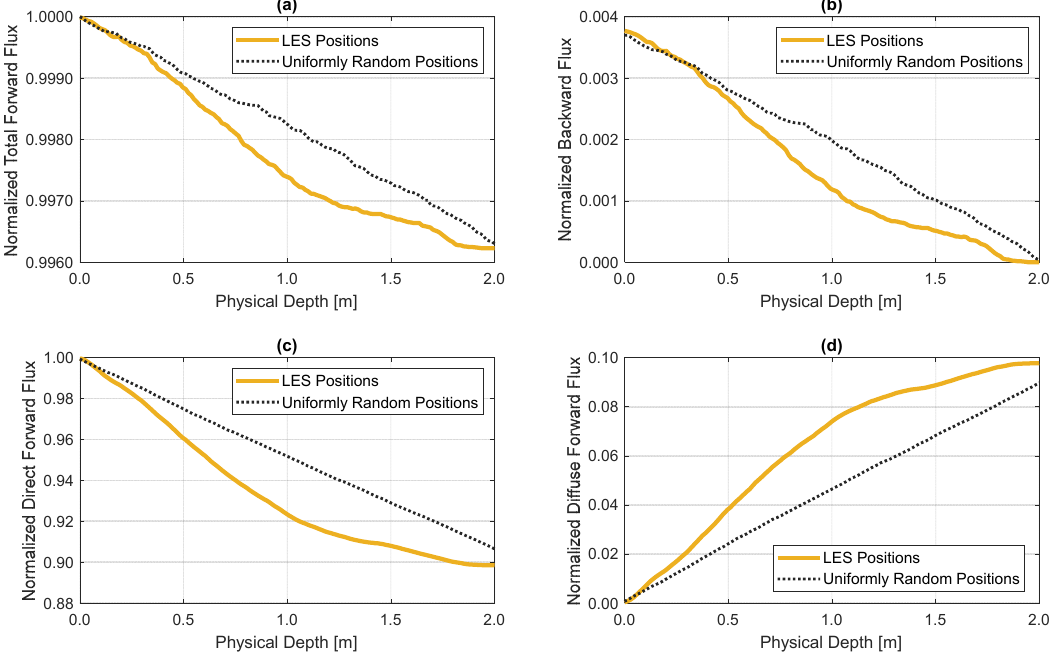
Figure 7. Normalized flux components from two scattering simulations which both employ the same particle size distribution function. As before, panels ( a )–( d ) show total forward, backward, direct forward and diffuse forward fluxes (respectively). The thick yellow line results from the use of LES-positioned droplet locations, while the dotted black line results from the use of uniformly random particle positions.